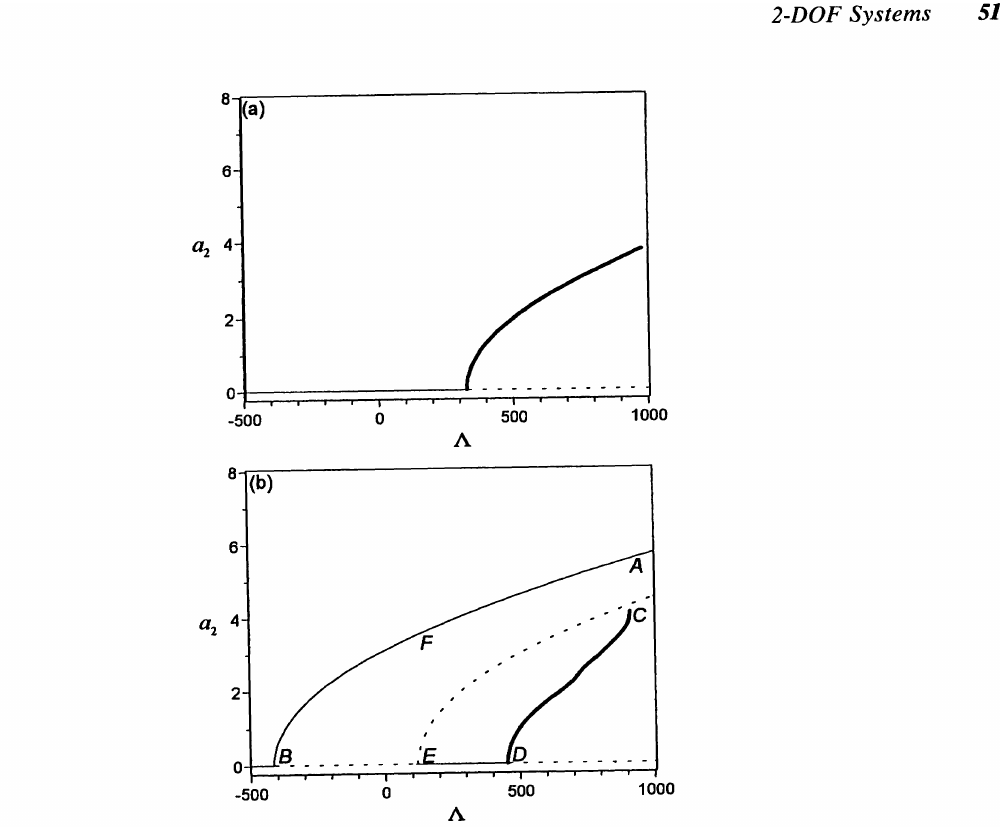
FIGURE 6 Variation of the amplitude of the second mode a2 with the aerodynamic detuning: (a) F = 200; (b) F = 350. Thin-solid lines denote stable constant solutions, dotted lines denote unstable constant solutions, and thick-solid lines denote the mean amplitude of the periodic solutions.